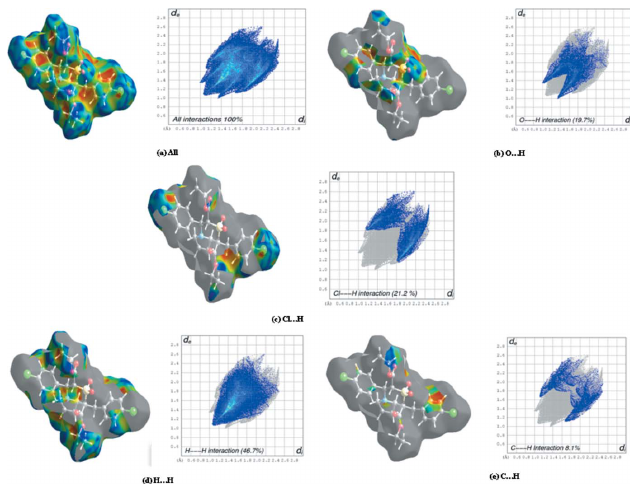
Figure 5 Hirshfeld surface of compound (I) mapped over shape-index and decomposed finger print plots of dominant interactions showing ( a ) all, ( b ) O (cid:2)(cid:2)(cid:2) H, ( c ) Cl (cid:2)(cid:2)(cid:2) H, ( d ) H (cid:2)(cid:2)(cid:2) H and ( e ) C (cid:2)(cid:2)(cid:2) H